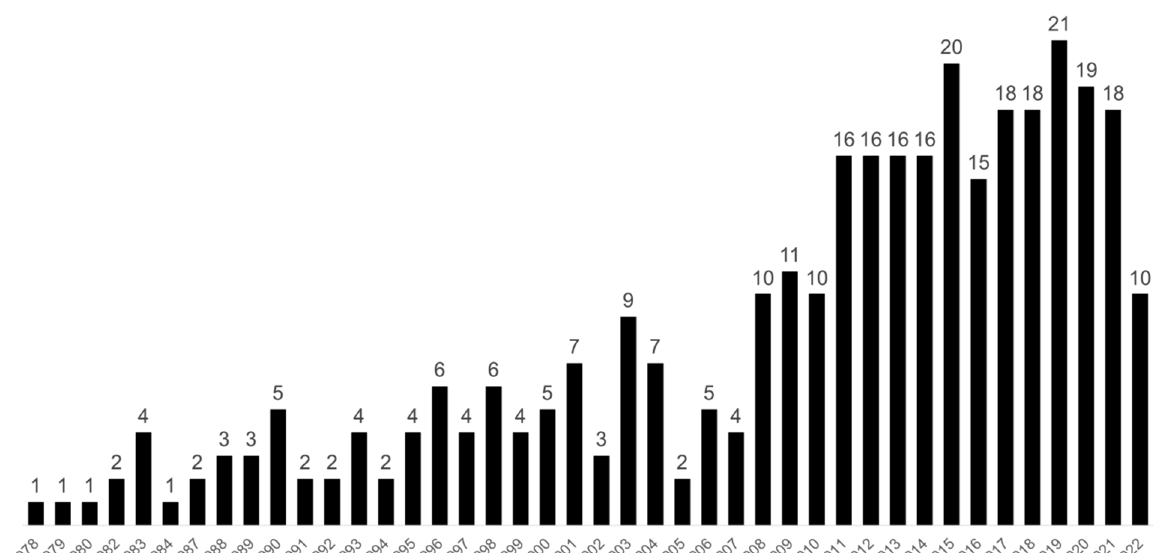
Figure 1. Special Olympics publications between 1978 and 4 March 2022.